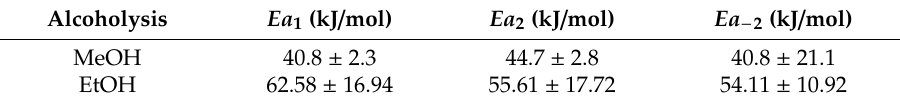
Table 3. The activation energies for each step of PLA alcoholysis to produce